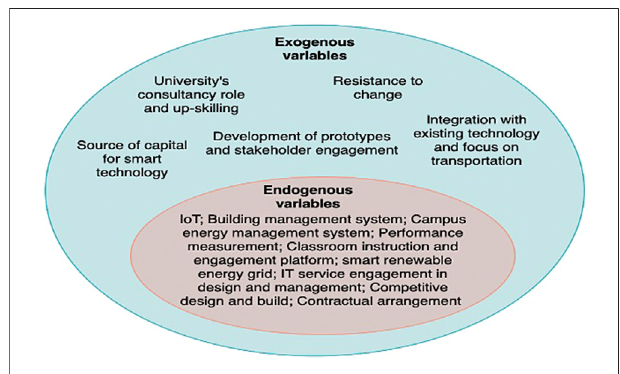
FIGURE 3 | Summary of interview fi ndings as exogenous and endogenous variables. Source: